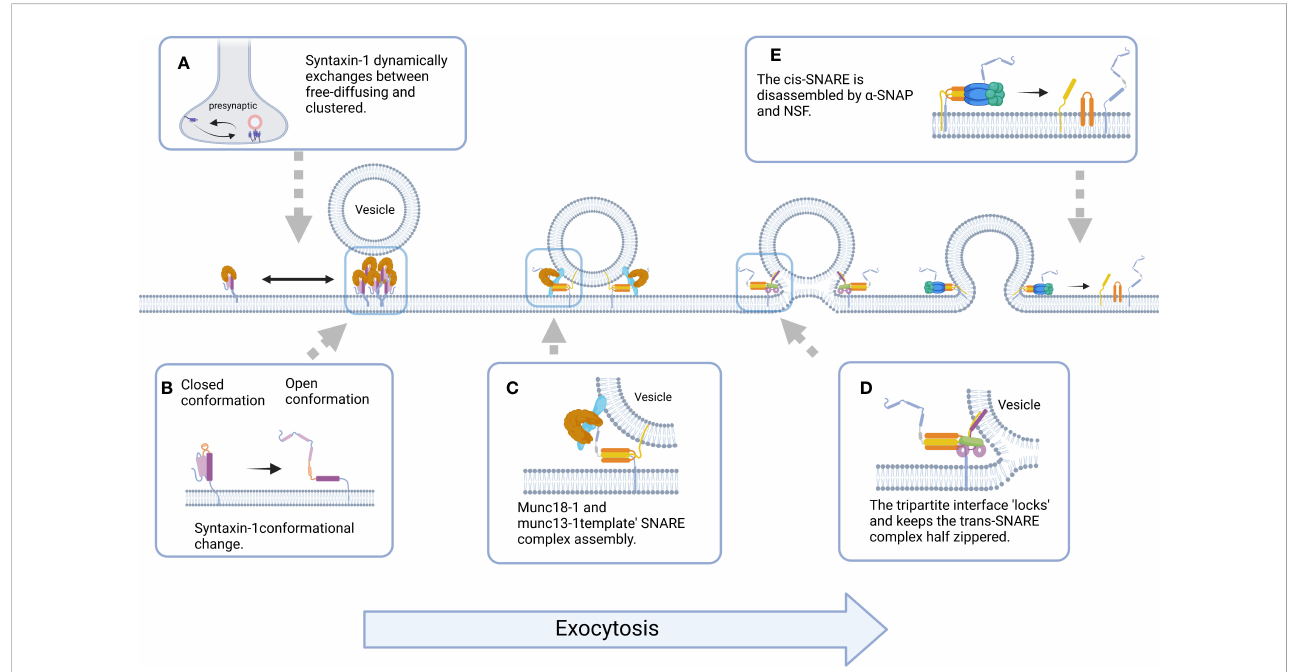
FIGURE 4 Schematic representation of the molecular events underlying Syntaxin-1-mediated exocytosis. (A) Syntaxin-1 molecules constantly switches between freely diffusing (mobile) and clustered (immobile) states at the plasma membrane, and Syntaxin-1 clusters could act as docking and fusion sites for secretory vesicles. (B) The switch between the closed and open conformation of Syntaxin-1 is a switch for membrane fusion. (C) Munc18-1 and Munc13- 1 ‘ template ’ SNARE complex to ensure assembly of SNAREs proteins into pathway product. (D) The tripartite SNARE-complexin-synaptotagmin-1 complex has to be unlocked for triggered fusion to commence, which contributes to synchronizing evoked release on the sub-millisecond timescale. (E) Binding of a -SNAP and NSF to cis-SNARE leads to the disassembly of SNAREs and the release of proteins involved in vesicle fusion. (All fi gures created with